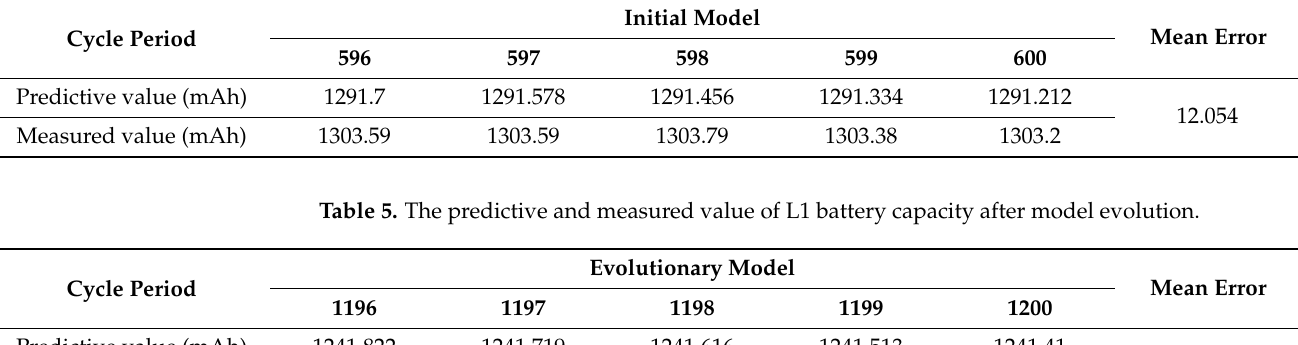
Figure 9. Evolution of the digital twin model for the reliability of batteries. Table 4. The predictive and measured value of L1 battery capacity.